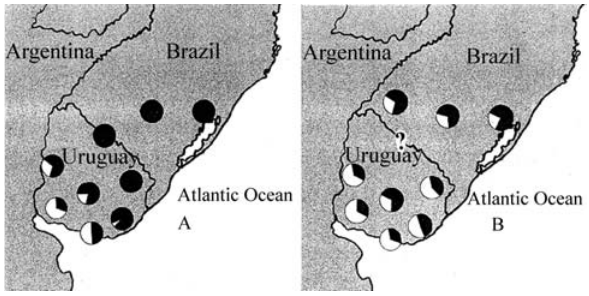
Figure 1 - A - Distribution of mtDNA haplotypes in honeybee popula- tions sampled in Uruguay and southern Brazil. Black denotes proportion of haplotypes having African origin ( A. m. scutellata ), while white de- notes proportion of haplotypes having European origin ( A. m. ligustica , A. m. mellifera and Portuguese*). *See text. B - Admixture estimates for Af- ricanandEuropeansubspeciescontributionstopopulationstructurebased